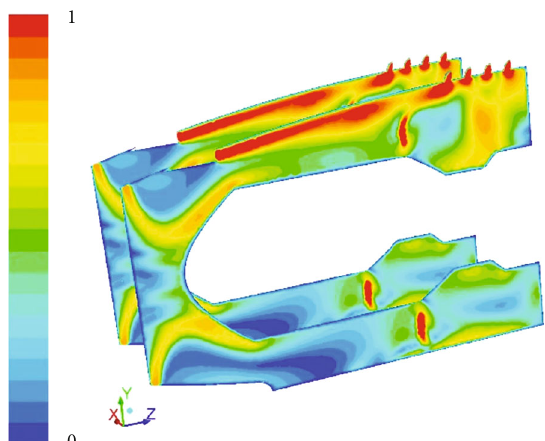
Figure 6: Vector velocity contours in two parallel vertical plains located in the middle of the rear